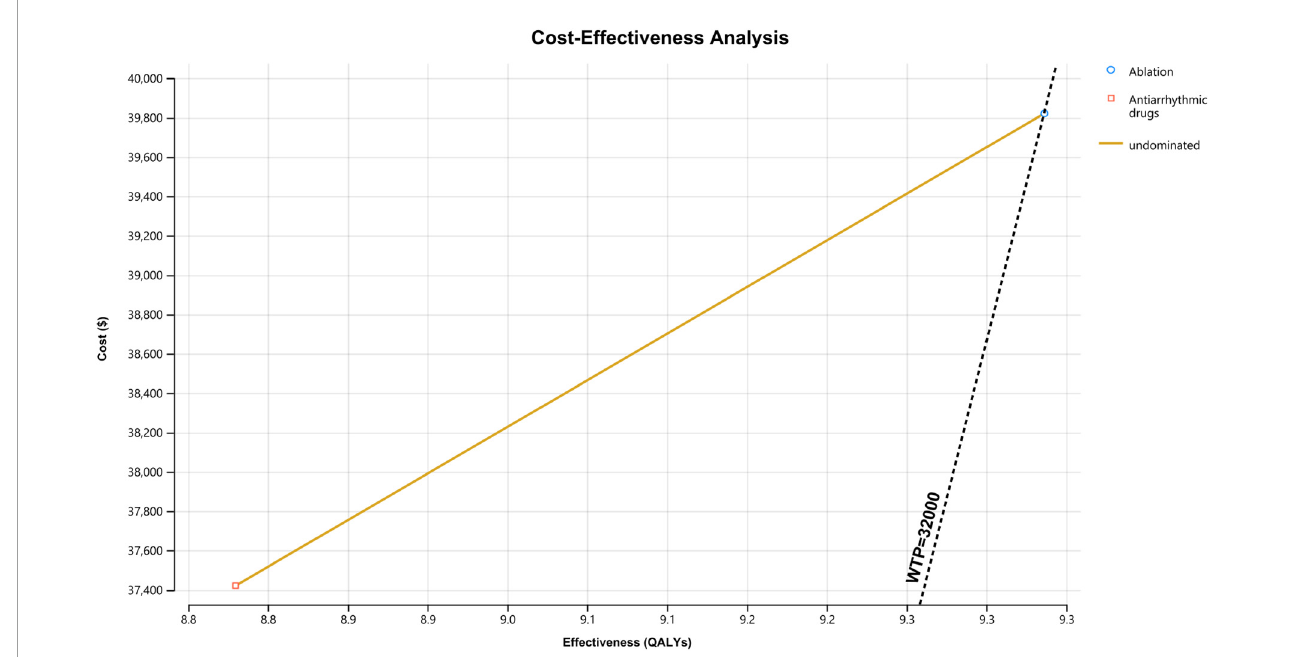
FIGURE2 Cost-effectiveness analysis curve of ablation vs. antiarrhythmic drugs for treating atrial fibrillation. WTP, willingness to pay; QALY, quality-adjusted life year.